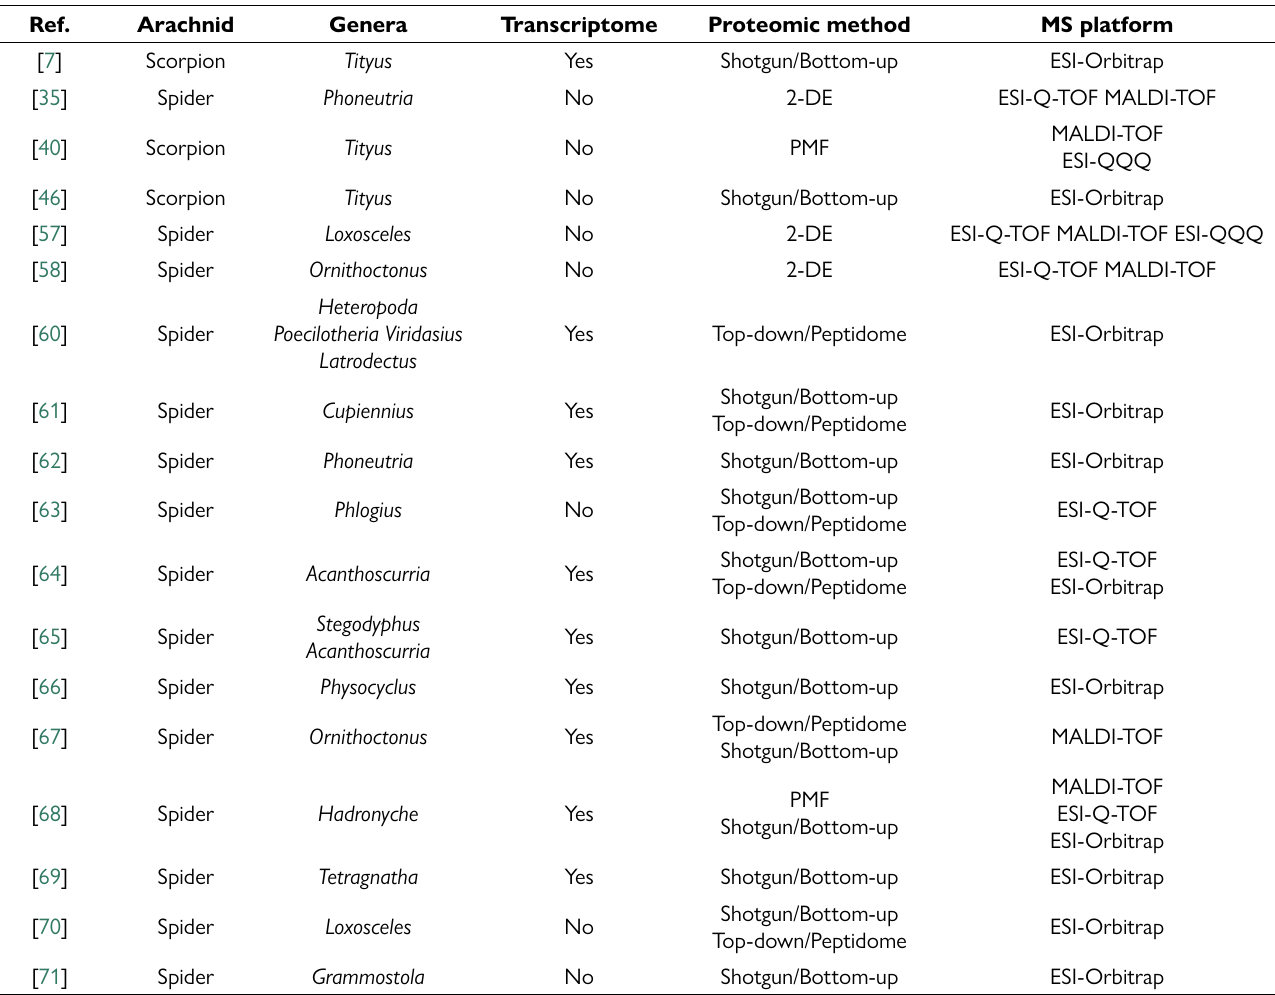
Table 1. List of publications on spider and scorpion venomics cited in this review.